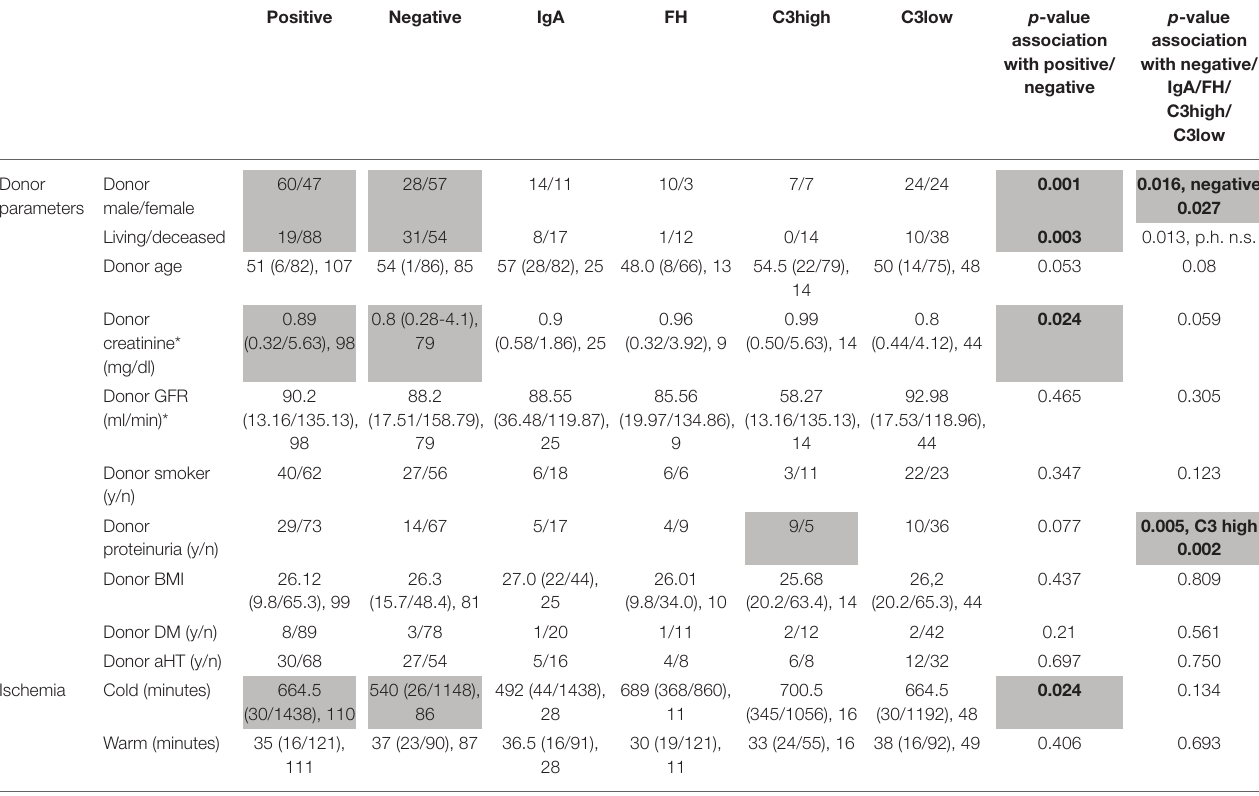
TABLE 2 | Comparison of donor parameters and ischemia time in immunohistochemical subgroups of time zero biopsies.